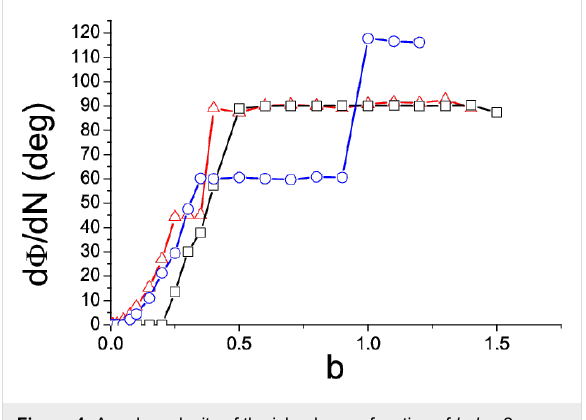
Figure 4: Angular velocity of the islands as a function of b . k = 2 (squares), k = 3 (circles) and k = 4 (triangles).